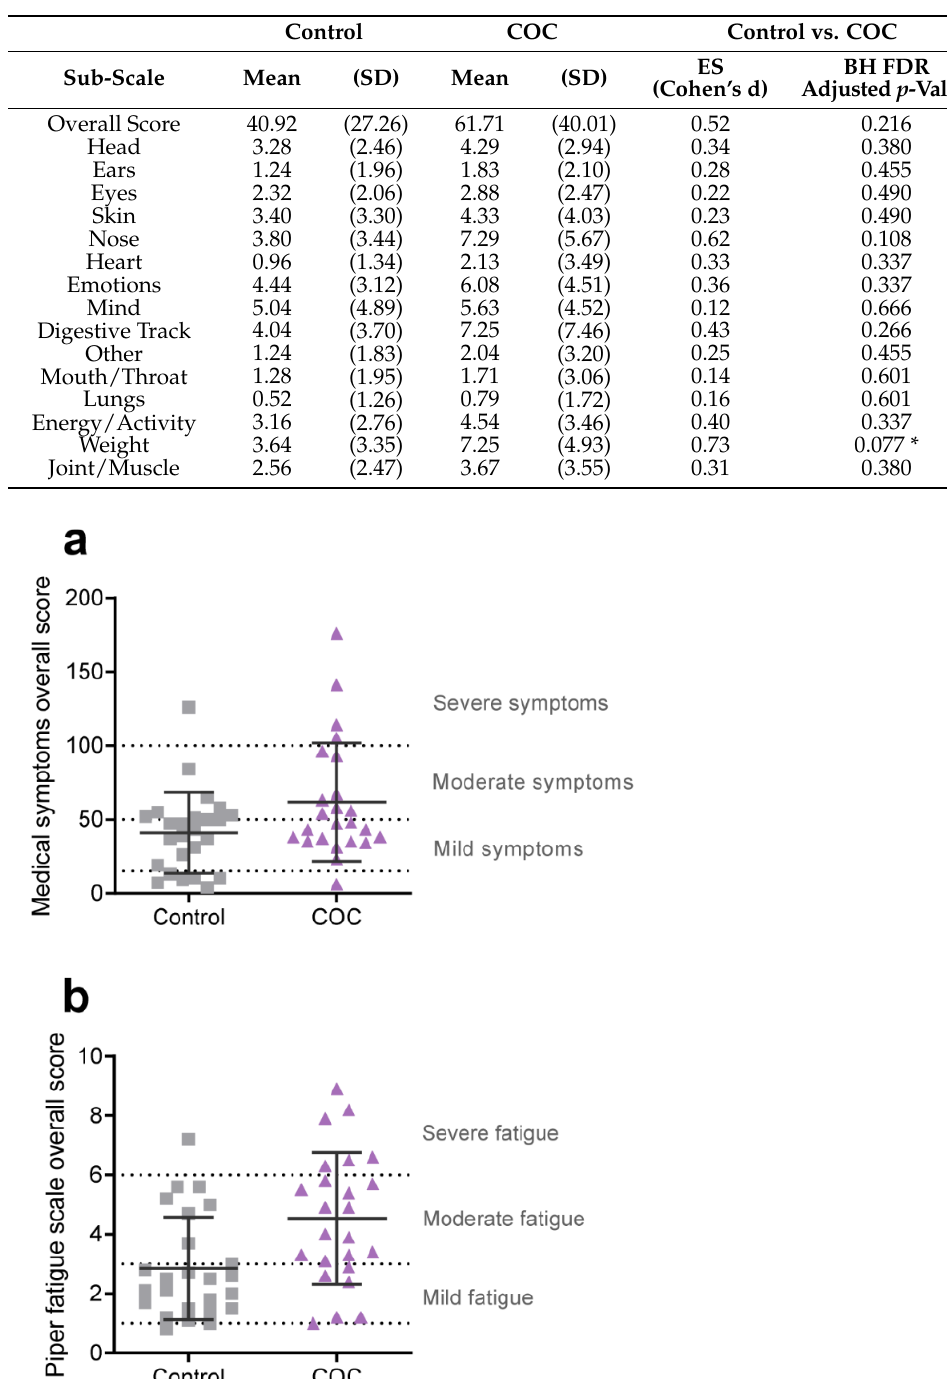
Table 2. Results from the Medical Symptoms Questionnaire (MSQ). SD, Standard deviation. ES, effect size. Cohen’s d value: 0.2, small effect; 0.5, medium effect; 0.8, large effect; 1.3, very large effect. * The BH FDR adjusted p -value was considered significant when ≤ 0.1.